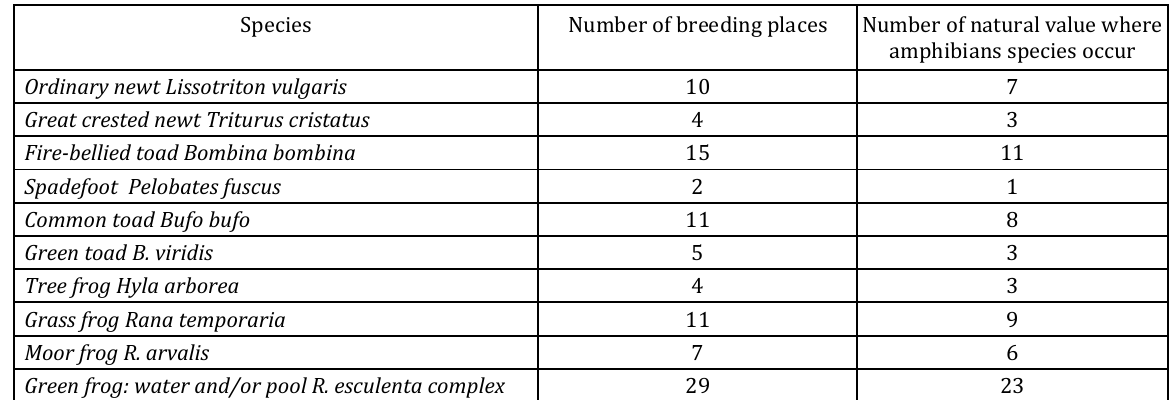
Table 2. Number of amphibians breeding places in